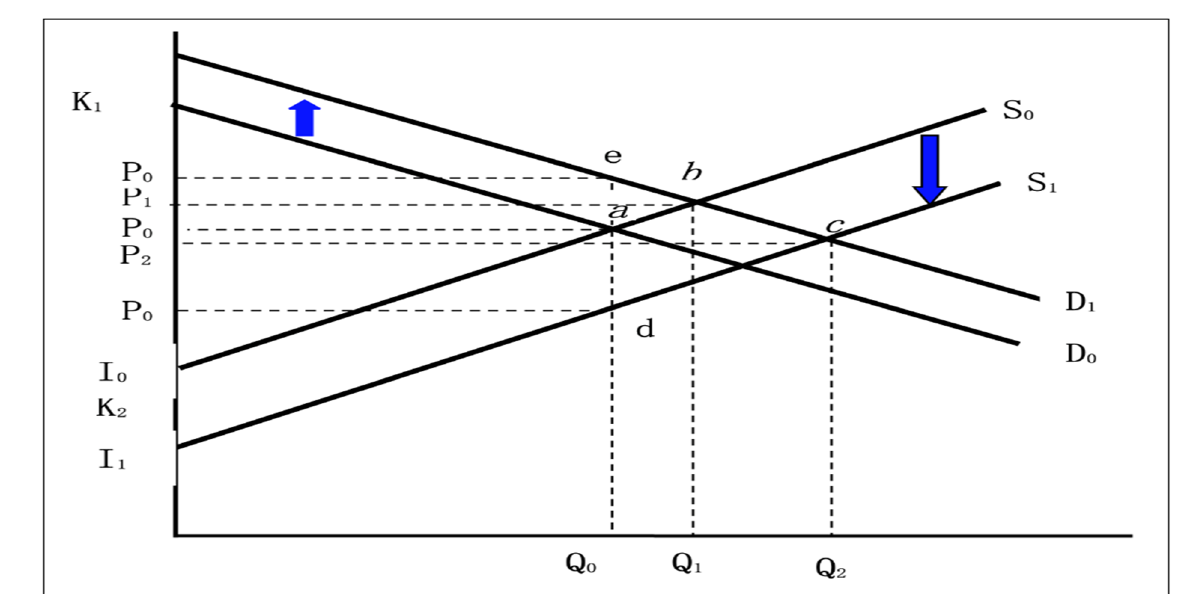
Figure 2. Supply and demand of kiwifruit commodity market brought by honeybee pollination Figure 2. technology.